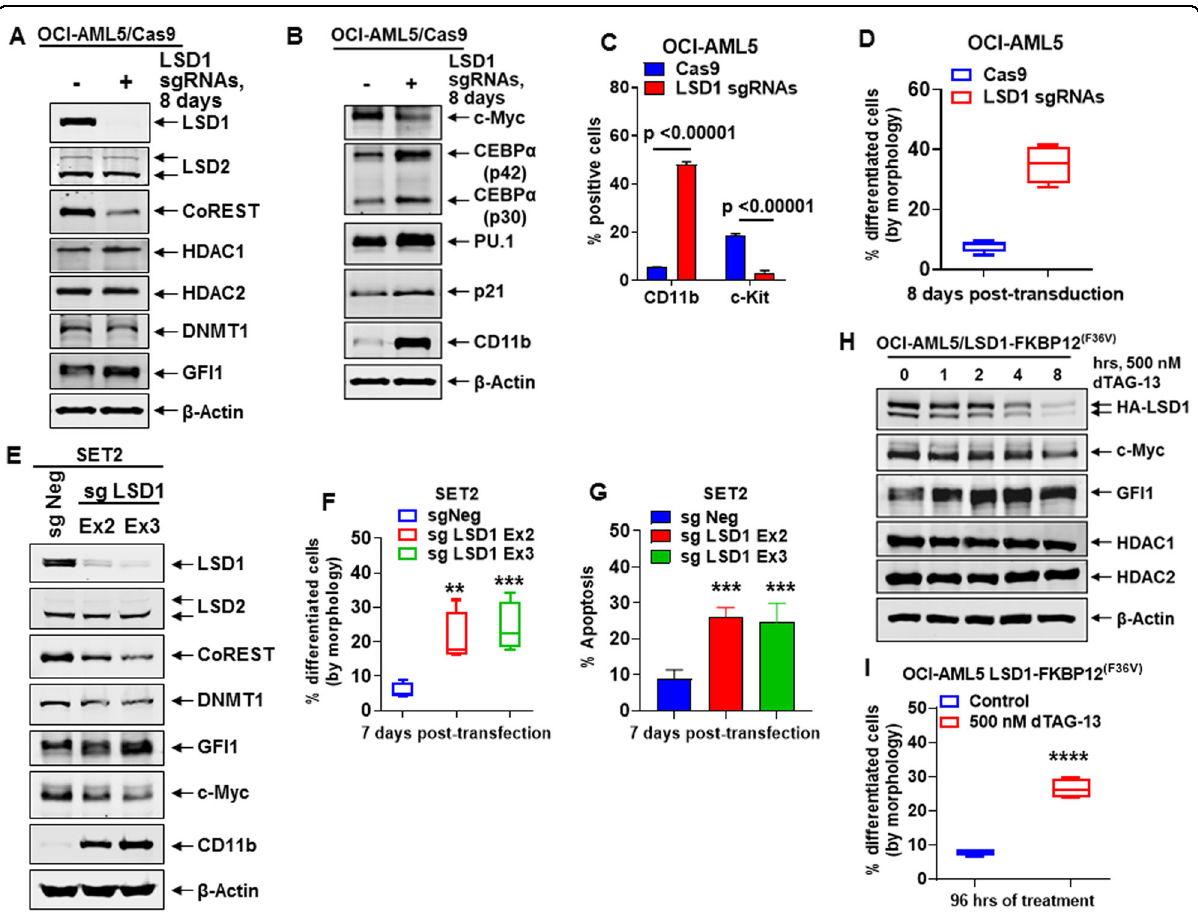
Fig. 1 Knockout of LSD1 by CRISPR/Cas9 depletes c-Myc, and derepresses myeloid differentiation gene CD11b in AML and sAML cells. A, B Representative immunoblot analysis of OCI-AML5 Cas9- expressing cells transduced with two lentiviral sgRNAs against LSD1 and incubated for 8 days. C Expression of c-Kit and CD11b (assessed by fl ow cytometry) in OCI-AML5 Cas9 and LSD1 knockout cells 8 days post-transduction. Mean of two independent experiments performed in duplicate + S.D. Signi fi cance determined by a two-tailed, unpaired t -test. D Morphologic differentiation (% myelocytes and metamyelocytes or bands by morphologic features of hematoxylin & eosin-stained cytospun cells) of OCI-AML5 Cas9 and LSD1 knockout cells 8 days post-transduction. Mean of two independent experiments performed in duplicate + S.D. E Representative immunoblot analysis of SET2 cells transfected with two sgRNAs against LSD1 and incubated for 7 days. F, G Induction of morphologic differentiation (% myelocytes and metamyelocytes or bands by morphologic features of hematoxylin & eosin-stained cytospun cells) and apoptosis in SET-2 LSD1 knockout cells 7 days post-transfection. Mean of two independent experiments performed in duplicate + S.D. ** p < 0.01, *** p < 0.005 compared to sgNeg-transfected SET- 2 cells (determined by a two-tailed, unpaired t -test). H Immunoblot analysis of OCI-AML5/LSD1-FKBP12( F36V ) cells treated with 500 nM of dTAG-13 for the indicated times. I OCI-AML5/LSD1-FKBP12( F36V ) cells were treated with 500 nM of dTAG-13 for 96 h. At the end of treatment, differentiation was assessed by cell morphology, as described above. Mean of three experiments + S.D. **** p < 0.001 compared to untreated control cells (determined by a two-tailed, unpaired t